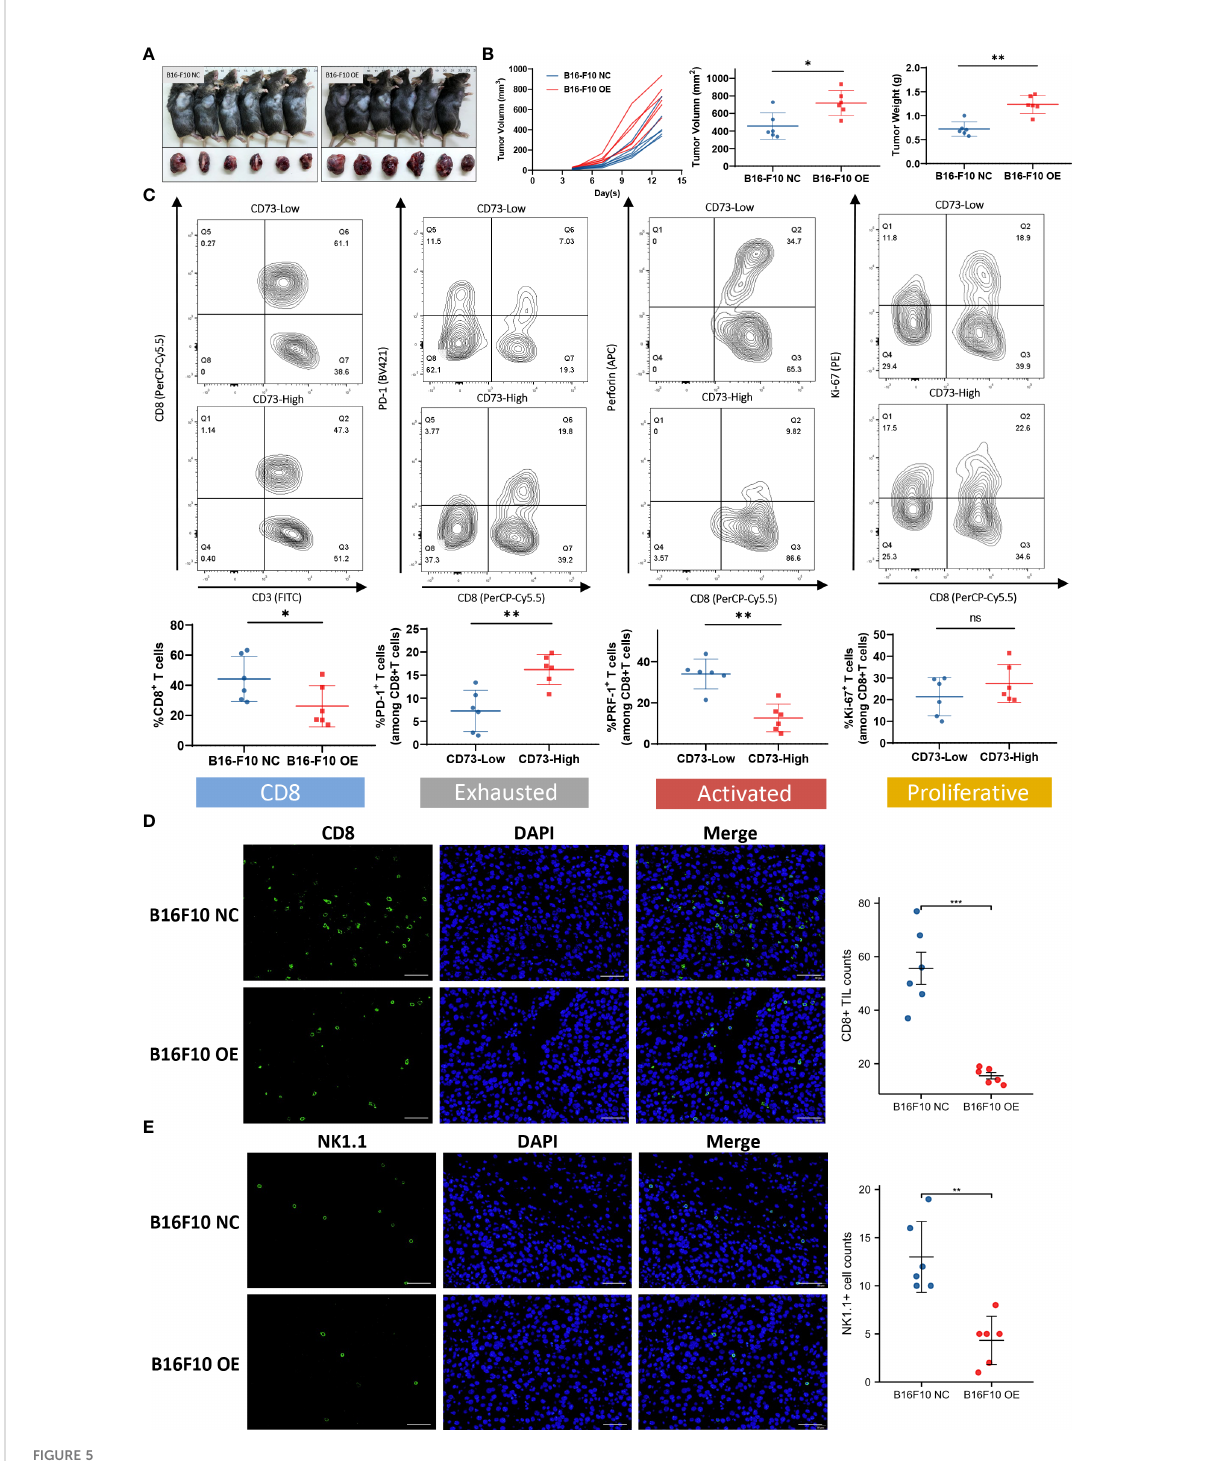
FIGURE 5 CD73 promoted melanoma growth and was associated with CD8 + T cell in fi ltration and exhaustion. Tumor xenografts of C57BL/6 mice were established by using CD73-NC and CD73-OE B16-F10 cells (A, B) . CD8 + T cell in fi ltration level in CD73 high and CD73 low subgroup. Expression of immune exhausted markers, activated markers and proliferative markers for total CD8 + T cells in CD73 high and CD73 low subgroup (C) . CD8 + T cells and NK1.1 + cells in fi ltrated in CD73-NC and CD73-OE tumors (D, E) . *p<0.05; **p<0.01; ***p<0.001; ns, no signi fi